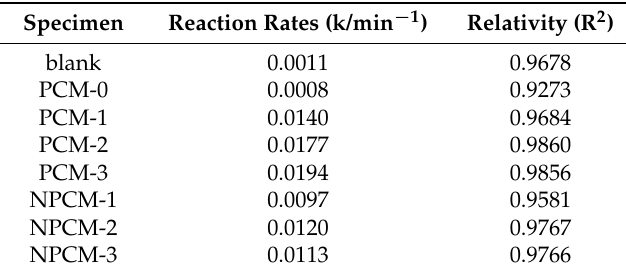
Figure 11. The cycling degradation rate of acetone by PCM-3. Table 6. The reaction rates and relativity.